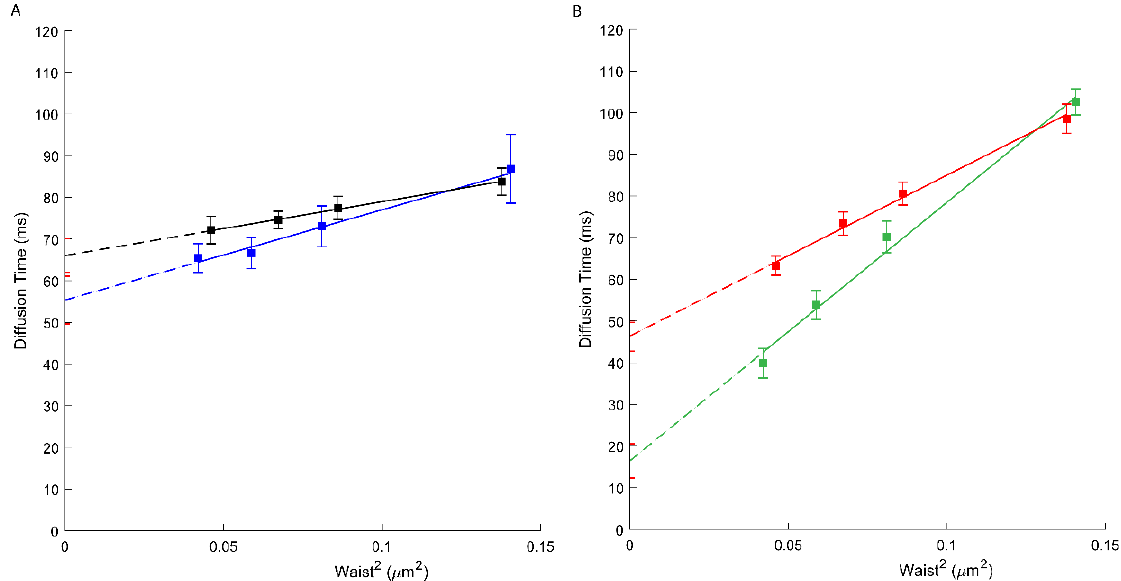
Figure 1. ( A ) svFCS diffusion laws for an active ABCA1 in non-treated A1G cells (black) and after amphotericin B treatment (blue). ( B ) svFCS diffusion laws for a non-active ABCA1MM in non-treated MMG cells (red) and after amphotericin B treatment (green). Table 1. Summary of the diffusion parameters—t 0 and D eff for ABCA1 (A1) and ABCA1MM (MM) .